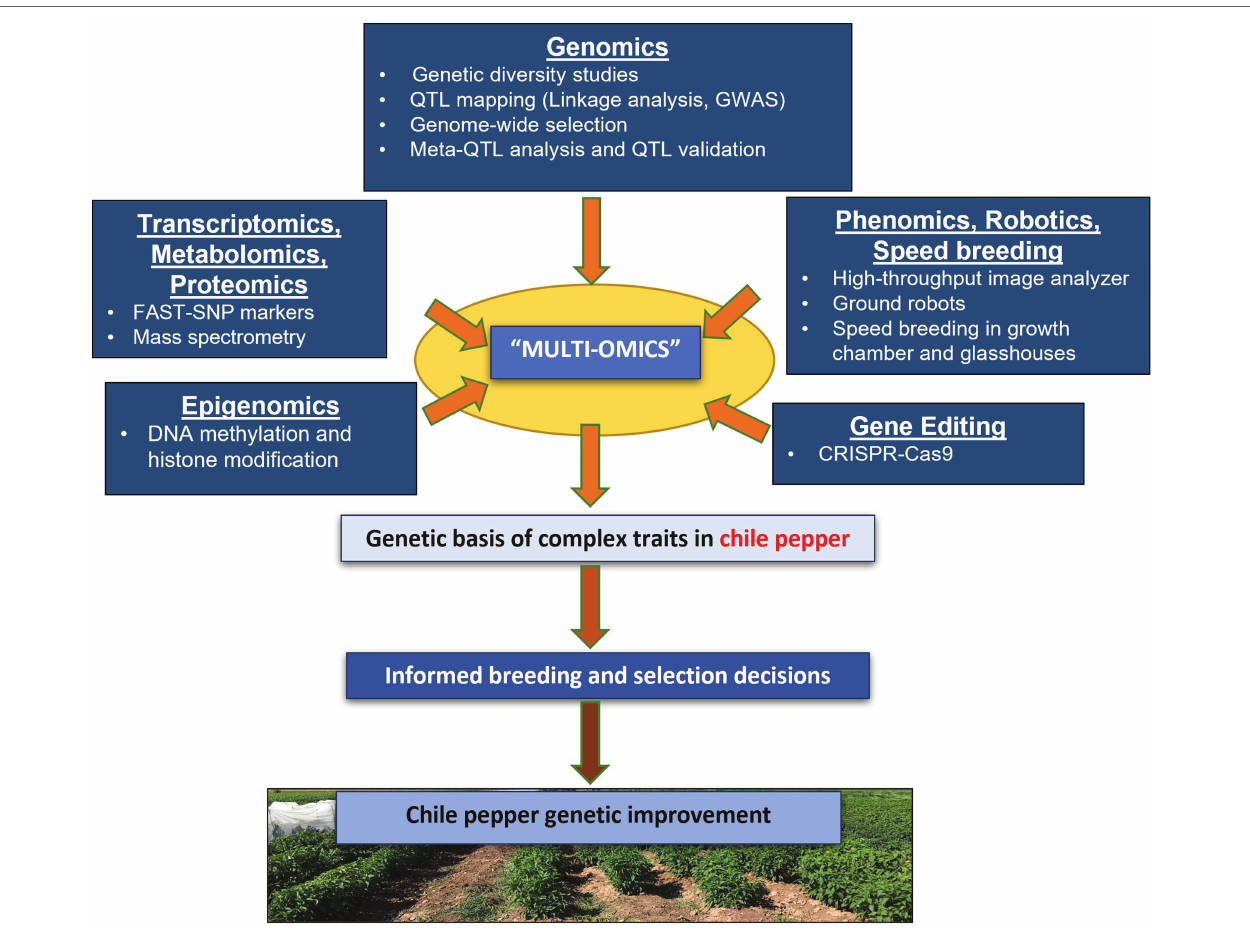
FIGURE 1 | Harnessing the power of multi-omics approaches for genetic improvement in chile pepper. Genomics-assisted breeding approaches, including genetic mapping (GWAS and QTL analysis) and genomic selection can facilitate the dissection of the genetic basis of complex traits in chile pepper by identifying genomic regions associated with important traits. Transcriptomics and epigenomics can render further insights into the expression and regulation of expression of these genetic systems. Gene editing (e.g., using CRISPR-Cas9) allows a precise and accurate modification of genes using a guide RNA (gRNA) for a targeted alteration of the genomic sequence, whereas phenomics approaches can expedite trait collection in the field. Speed breeding can accelerate development to increase genetic gain. Breeders can ultimately use the information derived from these various omics tools either exclusively or in combination with other approaches to select for and develop improved cultivars of chile